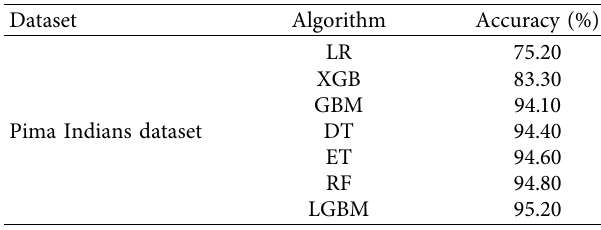
Table 2: Comparison of all classifiers.